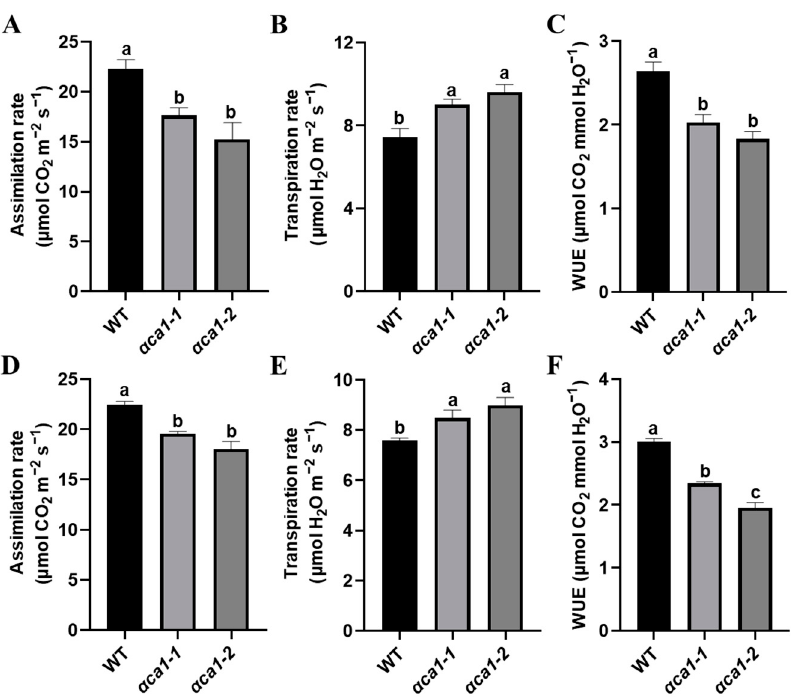
Figure 2. The photosynthesis rate was signi fi cantly lower in α ca1 than in WT seedlings. ( A – C ) The gas exchange parameters of WT and α ca1 at the vegetative growth stage. ( A ) Assimilation rate; ( B ) transpiration rate; ( C ) water use efficiency (WUE). The first fully expanded leaves of 2-week-old seedlings were measured. ( D – F ) The gas exchange parameters of WT and α ca1 at the reproductive growth stage. ( D ) Assimilation rate; ( E ) transpiration rate; ( F ) WUE. The flag leaves were measured. Values are shown as means ± SEM determined via one-way ANOVA, where different letters indicate a signi fi cant di ff erence. p < 0.05; n ≥ 9.